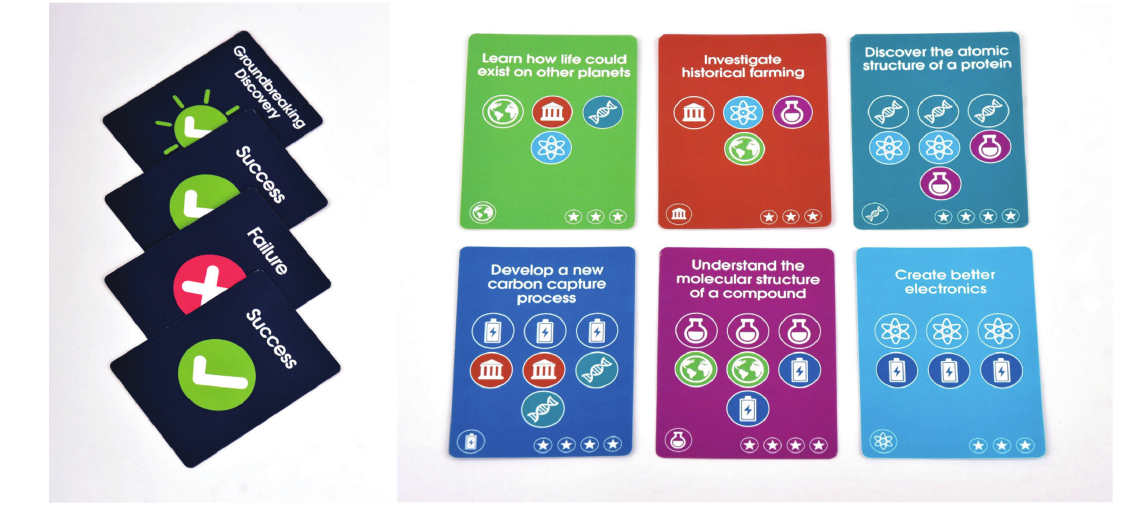
Figure 6. Examples of cards from the Experiments deck and the Projects deck (Source: Authors, 2022; Diamond Light